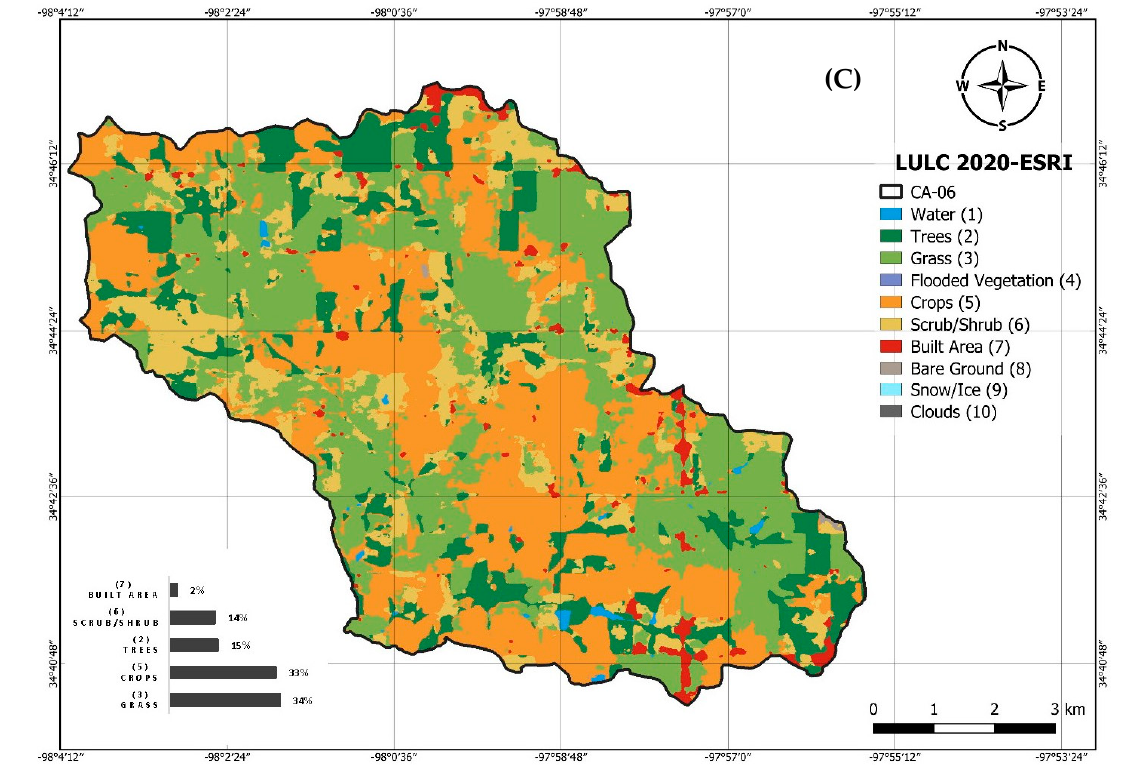
Figure A6. DEM and land-use maps for Catchment CA-06 ( A ) DEM, ( B ) NLCD 2019 land-use map, ( C ) LULC 2020-ESRI land-use map.